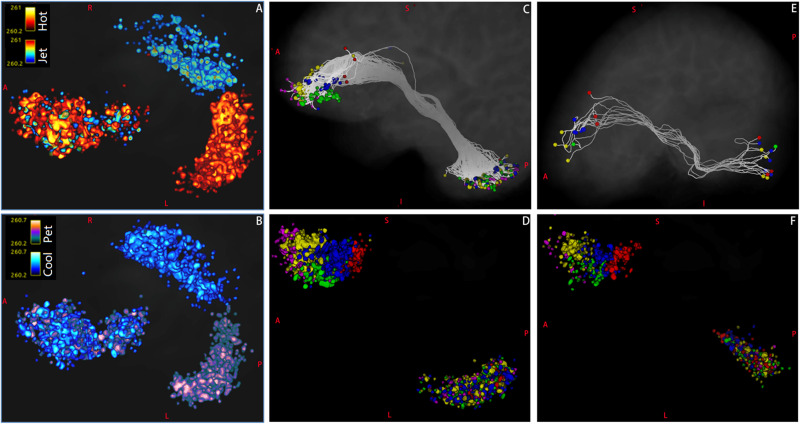
The distributions of endpoints of Crus–Broca tracts and Broca–Crus tracts as reconstructed via MRtrix3. (A) The distribution patterns of target points (in matlab_hot colormap) of the left Crus–Broca tracts in five Broca regions of interest (ROIs) are not obviously different from those (in matlab_jet colormap) of the right Crus–Broca tracts. (B) This trend is true in the origin points of Broca–left-Crus tracts (in matlab_pet colormap) and Broca–right Crus tracts (in matlab_cool colormap) in five Broca ROIs. (C) In one representative subject (LS 2043), after the endpoints of left Crus II–Broca tracts (five tracts) have been colored by the colors of their target Broca ROIs in Figure 1B, the origin points of these five tracts mix with each other in the left Crus II ROI rather than locate at exclusive subregions of the left Crus II ROI according to their target Broca ROIs. This trend is true in left Crus II–Broca tracts from all subjects (D), Broca–right Crus II tracts from the same subject (E), and Broca–right Crus II tracts from all subjects (F). The color bar in each panel of the figure is from 0.2 to 0.5. The right two voxel clusters in (A,B) locate within bilateral Crus II ROIs, and the right voxel cluster in (C,D) locates within the left Crus II ROI; the right voxel cluster in (E,F) locates within the right Crus II ROI. The left voxel cluster in each panel locates within Broca ROIs.